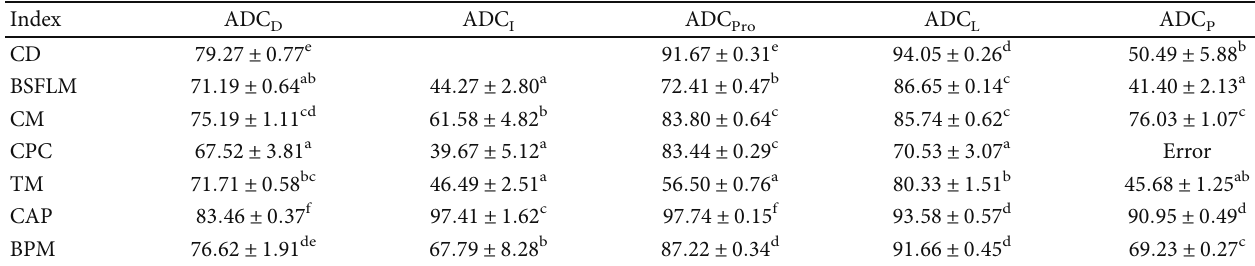
Data represents mean ± SEM of three replicates ( n = 3 ). Values in the same line with di ff erent letters are signi fi cantly di ff erent ( P < 0 : 05 ) based on Duncan ’ s test. The lack of superscript letter indicates no signi fi cant di ff erences among groups, where apparent digestibility coe ffi cient of dry matter (ADC